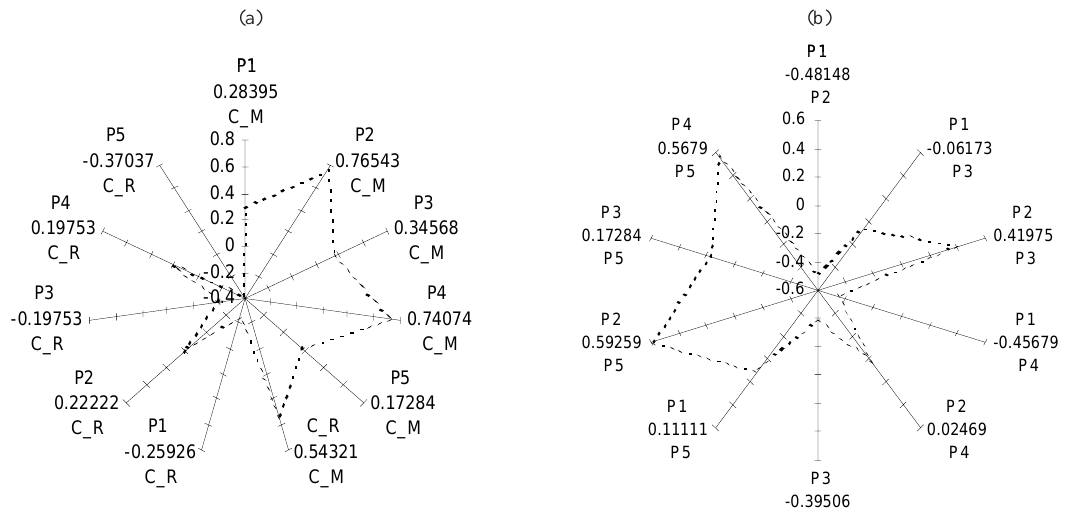
Figura 1. Tendências médias existentes entre as determinações do valor de matiz para amostras secas. Cada eixo refere-se a uma comparação e o seu valor é apresentado entre as siglas. Valores negativos subestimam e valores positivos superestimam as determinações de matiz na escala ordenada. (a) comparação entre as medições feitas por pesquisadores e pelo colorímetro. (b) comparação entre as medidas feitas apenas por